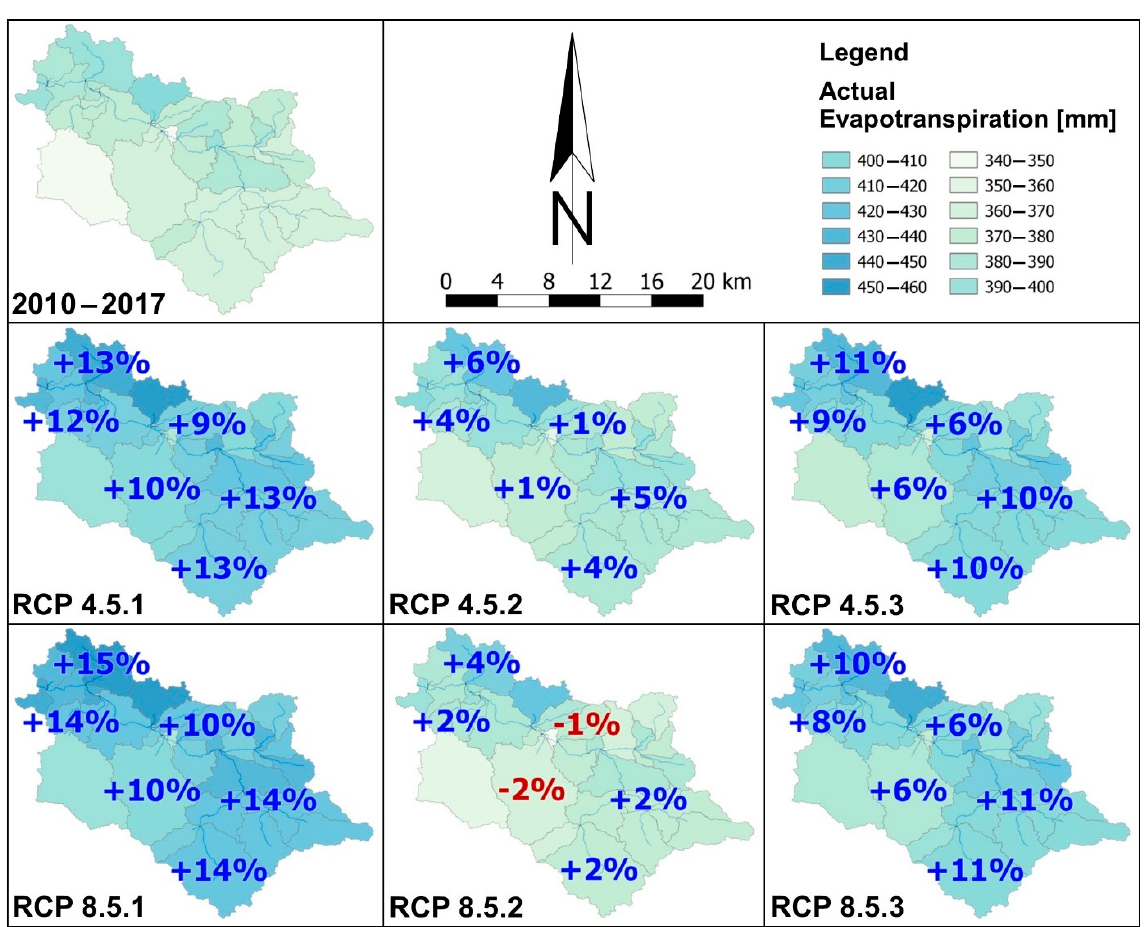
Figure 12. Comparison of the average sum of actual evapotranspiration in 31 sub-catchments for the SWAT simulation period for 2010–2017 and 2041–2050 for individual climate projections in the RCP 4.5 and RCP 8.5 scenarios (own study).